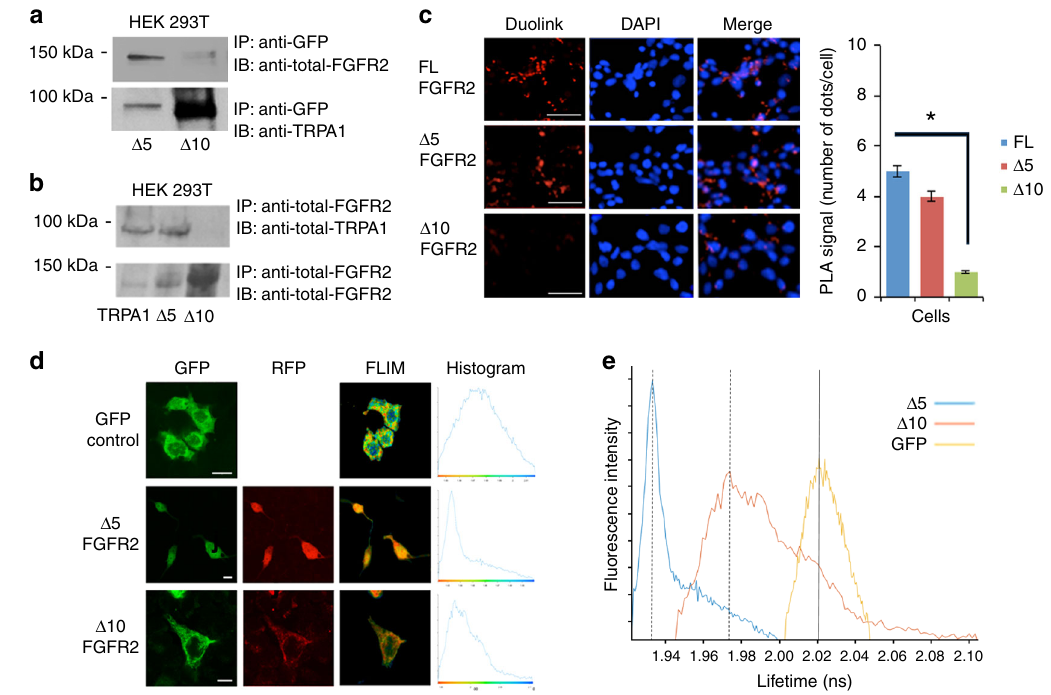
Fig. 2 FGFR2 binds to ankyrins 6 – 10 of TRPA1. a , b Western blot analysis of an IP with anti-GFP in ( a ) and anti-FGFR2 in ( b ) in HEK 293T cells that were co- transfected with full-length FGFR2 and N-terminal ankyrin repeat truncated TRPA1 ( Δ 5-GFP or Δ 10-GFP) followed by IB with the indicated antibodies. c Duolink assay results performed in HEK 293T cells that were co-transfected with FGFR2 and TRPA1 constructs. Scale bar: 50 μ m. The bar graph indicates the number of red dots (binding events) in the samples. Error bars, s.d. ( n = 3 biological replicates each with technical replicates). * P ≤ 0.05 by two-tailed Student ’ s t test. d , e FLIM experiment in HEK 293T cells co-transfected with FGFR2-RFP and Δ 5-GFP or Δ 10-GFP. Y-axis depicts the fl uorescence intensity. Scale bar is 10 μ m. HEK 293T cells that were transfected with an empty GFP vector (upper panel) were utilized as a control to establish the lifetime of GFP. Histograms (shown on the same scale) in ( e ) indicate lifetime changes in nanoseconds (ns), where a decrease in GFP lifetime (peak shift to the left of the yellow curve) correlates with a potential direct binding event between the two (Fig. 2a with anti-TRPA1 bands as an IP normalization control) or pulling-down with FGFR2, then probing for TRPA1 (Fig. 2b with anti-FGFR2 bands as an IP normalization control)